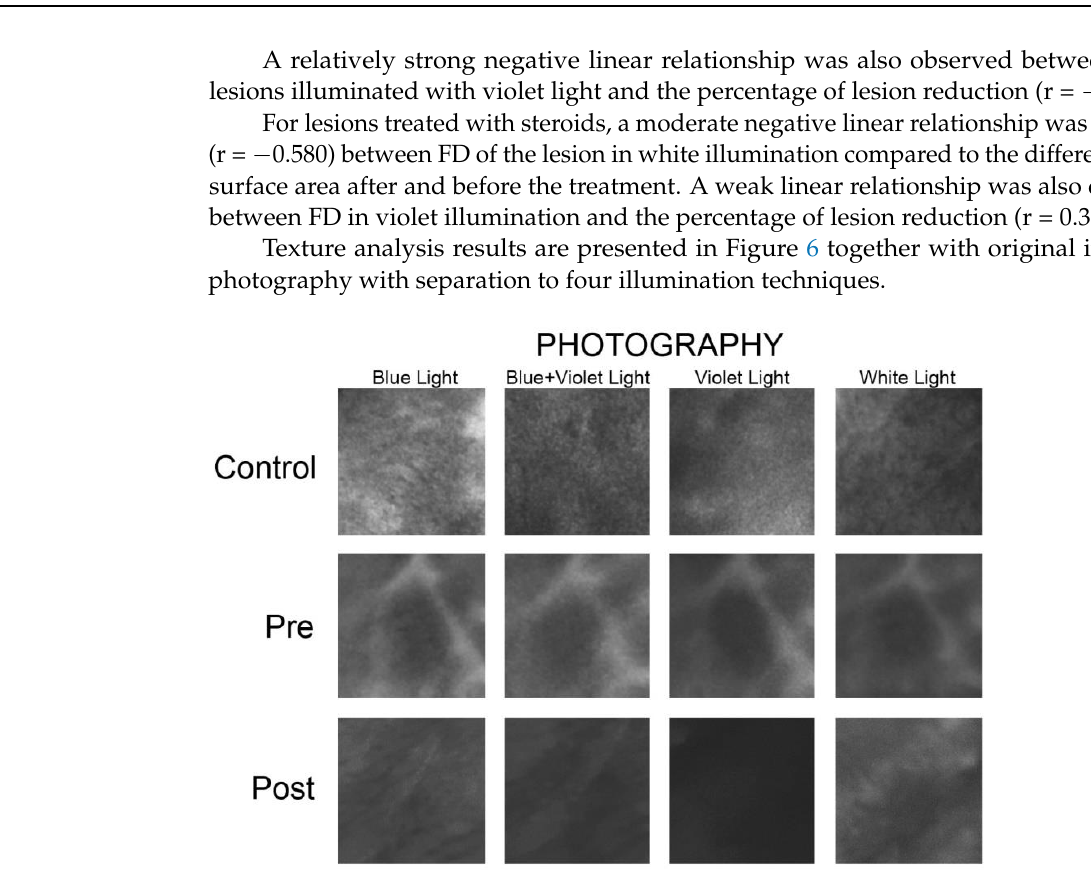
Figure 6. The upper panel consists of photographic images taken intra-orally under blue (450 nm), blue+violet (405 + 460 nm), violet (405 nm), and white light for control mucosa, lichen lesion pre- treatment, and lichen lesion post-treatment. The lower panel shows contrast distribution maps over the surface of the same photographs from the upper panel. White areas indicate areas of locally increased contrast in the image texture. On the contrary, dark areas indicate areas of low contrast (control—healthy mucous, Pre—lesion before treatment, Post—lesion after treatment). There were no statistically significant differences in lesion texture between the two treatment groups (Table 8). The lesion texture was the same in both groups at baseline (pre-treatment). An improvement in the texture of the treated lesion was noted only after steroid therapy by examining the lesion appearance under blue+violet light. In general, it can be seen that none of the treatment methods used unfortunately transforms the lesion to a textural appearance similar to that of normal mucosa. The relative superiority of ster- oid therapy over PDT can be seen in the blue-violet observations, where the microcontrast of the treated lesion significantly increased after the treatment cycle. Under white light, the lesion achieved the texture of normal mucosa (Control) after both steroid therapy as well PDT.